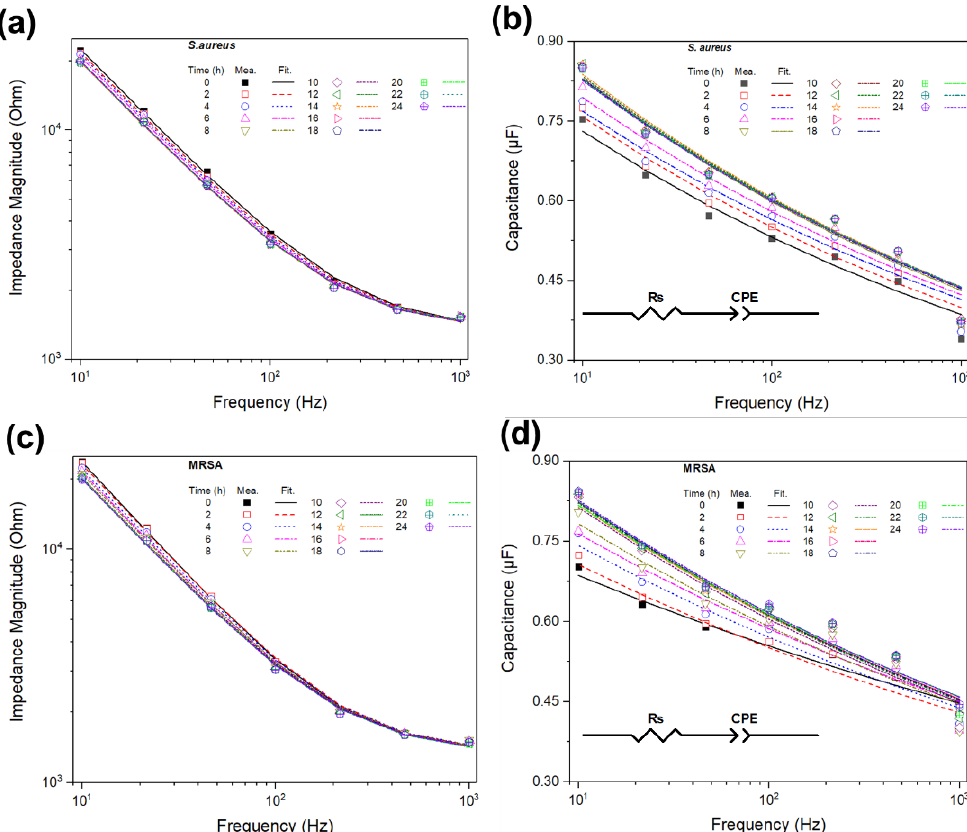
Figure 4. Impedance spectra and capacitance spectra for S. aureus ( a , b ) and methicillin-resistant S. aureus (MRSA) ( c , d ) during bacterial growth in Luria–Bertani (LB) medium. The data points represent the measured (mea.) impedance spectra. The dotted lines represent the fitting spectra (Fit.) using an equivalent circuit model, consisting of the solution resistance (R s ) and a double-layer capacitance (CPE). Table 2. Extrapolated values of the designed equivalent circuit parameters from the fitting results for S. aureus and MRSA in Figure 4.